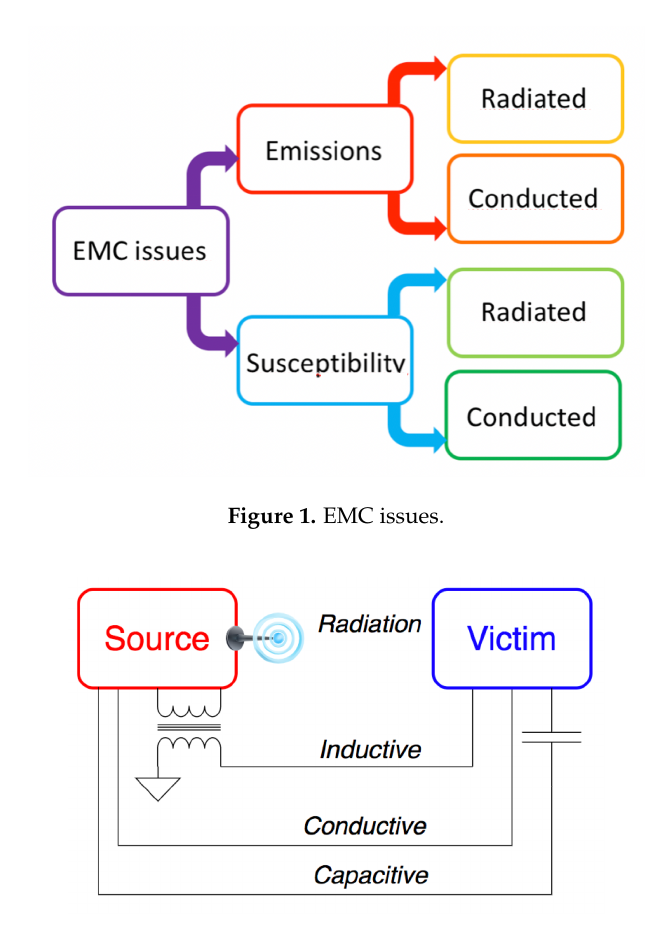
Figure 2. Possible coupling mechanisms for EMI